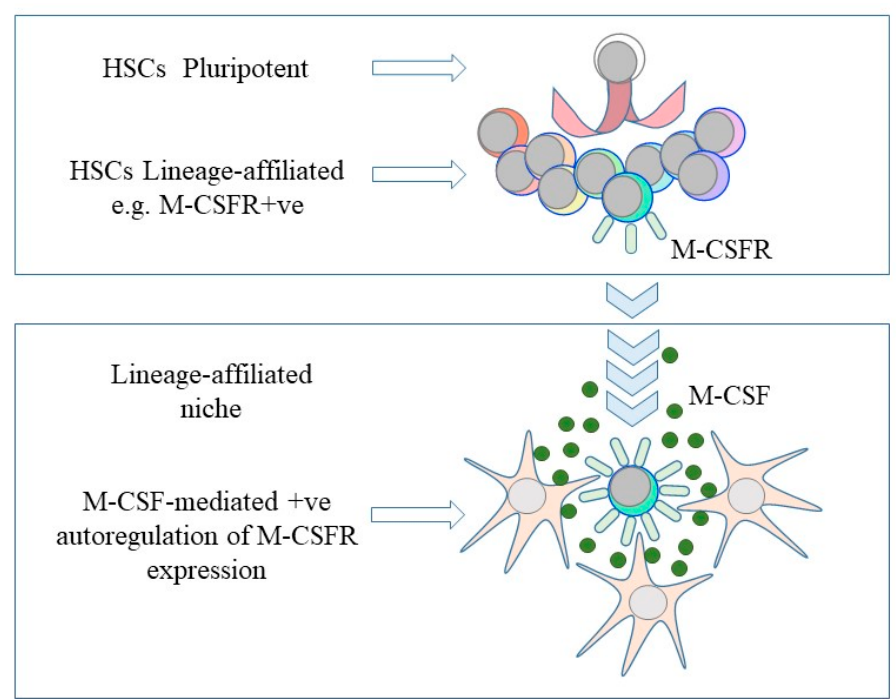
Figure 2. A continuum and niche model of the fate of hematopoietic stem cells. Hematopoietic stem cells (HSC) choose directly from all of the available fates and are primed towards a cell lineage by virtue of a low level of expression of the receptor for a lineage-affiliated cytokine, for example, the receptor for macrophage colony-stimulating factor (M-CSFR). The provision of, for example, macrophage colony-stimulating factor (M-CSF), bound to proximal cells and/or the extracellular matrix, positively autoregulates expression of the receptor to enforce development along the ‘chosen’ pathway.